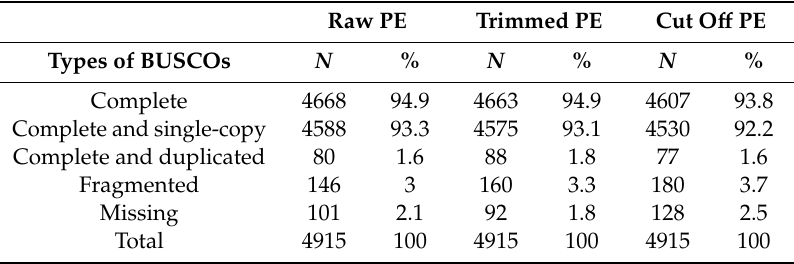
Table 6. Assembly completeness of three DISCOVARdenovo + SOAPdenovo2-assembled genomes based on BUSCO analyses. Types of BUSCOs indicate assessment output types of benchmarking universal single-copy orthologs.